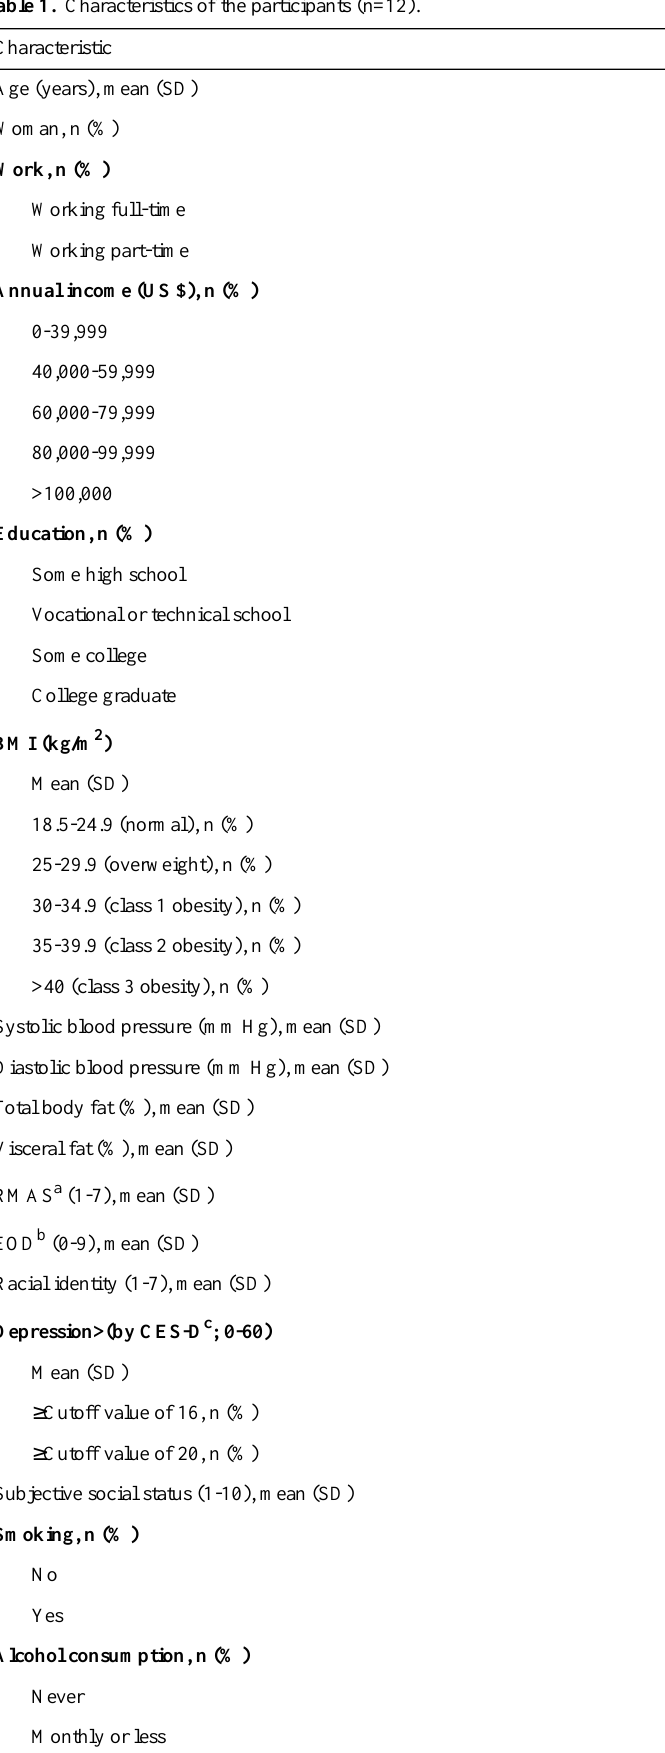
Table 1. Characteristics of the participants